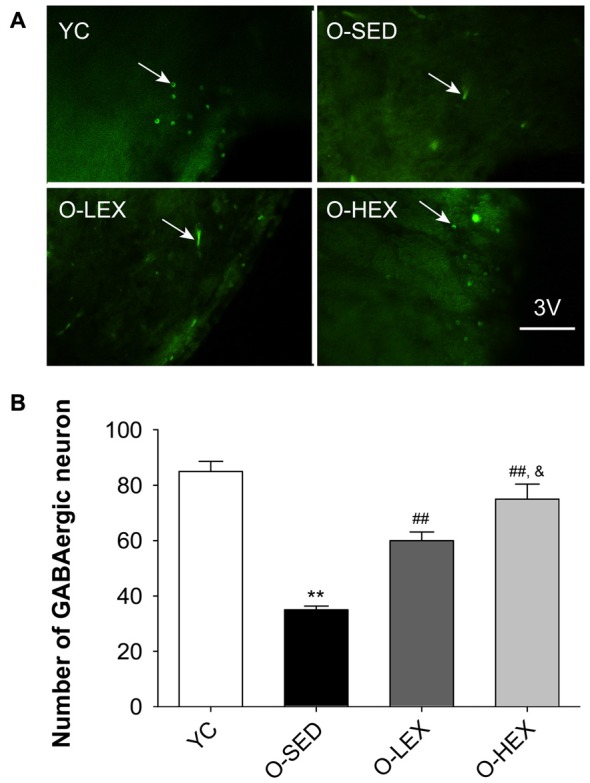
Effects of 12 weeks of aerobic exercise on the number of GABAergic neurons in the paraventricular nucleus (PVN). (A) Immunofluorescence staining of GABAergic neurons (GAD67-positive) in the PVN in YC, O-SED, O-LEX and O-HEX group, respectively. (B) Number of GABAergic neurons in the PVN in YC, O-SED, O-LEX and O-HEX group. 3V, the third ventricle. Scale bar = 50 μm. **p < 0.01 vs. YC; ##p < 0.01 vs. O-SED; &p < 0.05 vs. O-LEX. n = 7 in each group.